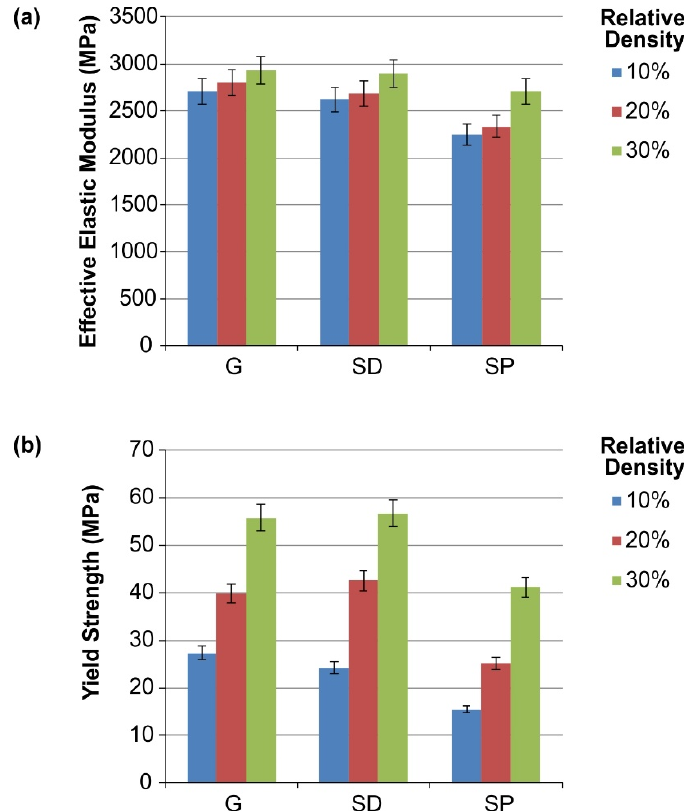
Figure 9. ( a ) Effective elastic modulus and ( b ) compressive yield strength for each TPMS structure.